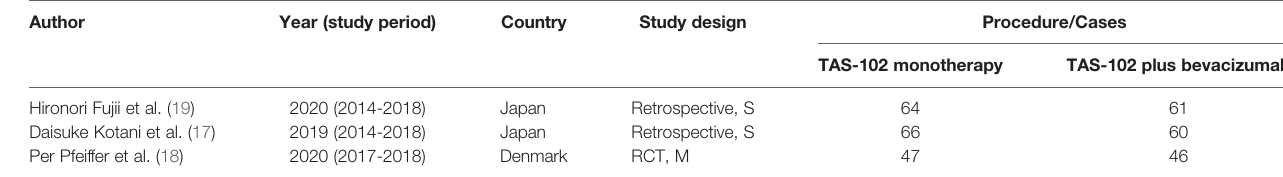
TABLE 1 | Published articles reporting onTAS-102 monotherapy or combined with bevacizumab for the treatment of metastatic colorectal